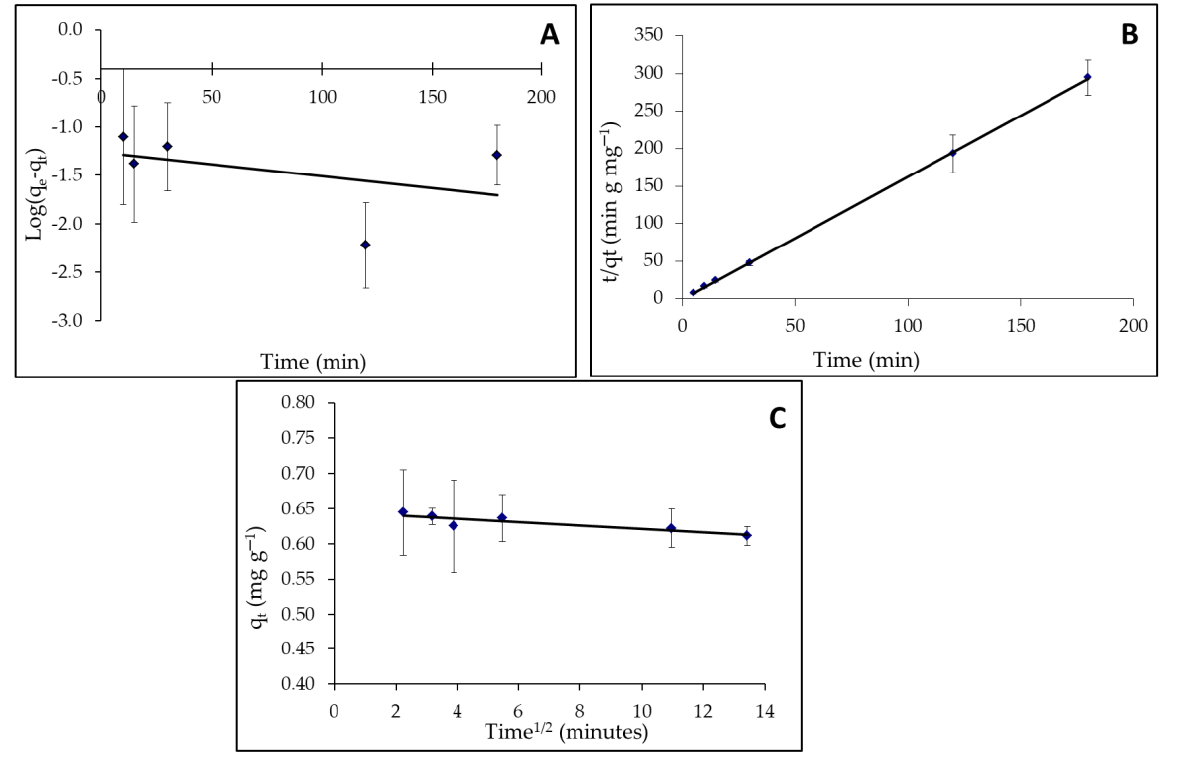
Figure 11. Adsorption kinetic models for MB on A. platensis nanoparticles; ( A ): pseudo-first-order; ( B ): pseudo-second-order; and ( C ) intra-particle diffusion plots. Table 4. Adsorption kinetic model rate constants for MB on A. platensis nanoparticles.